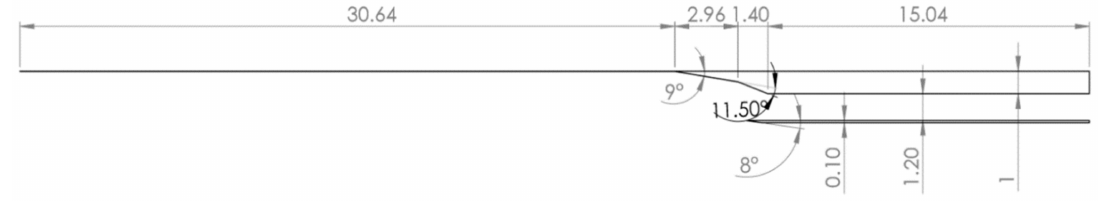
Figure A2. Two ramp inlet schematic (dimensions in metres).